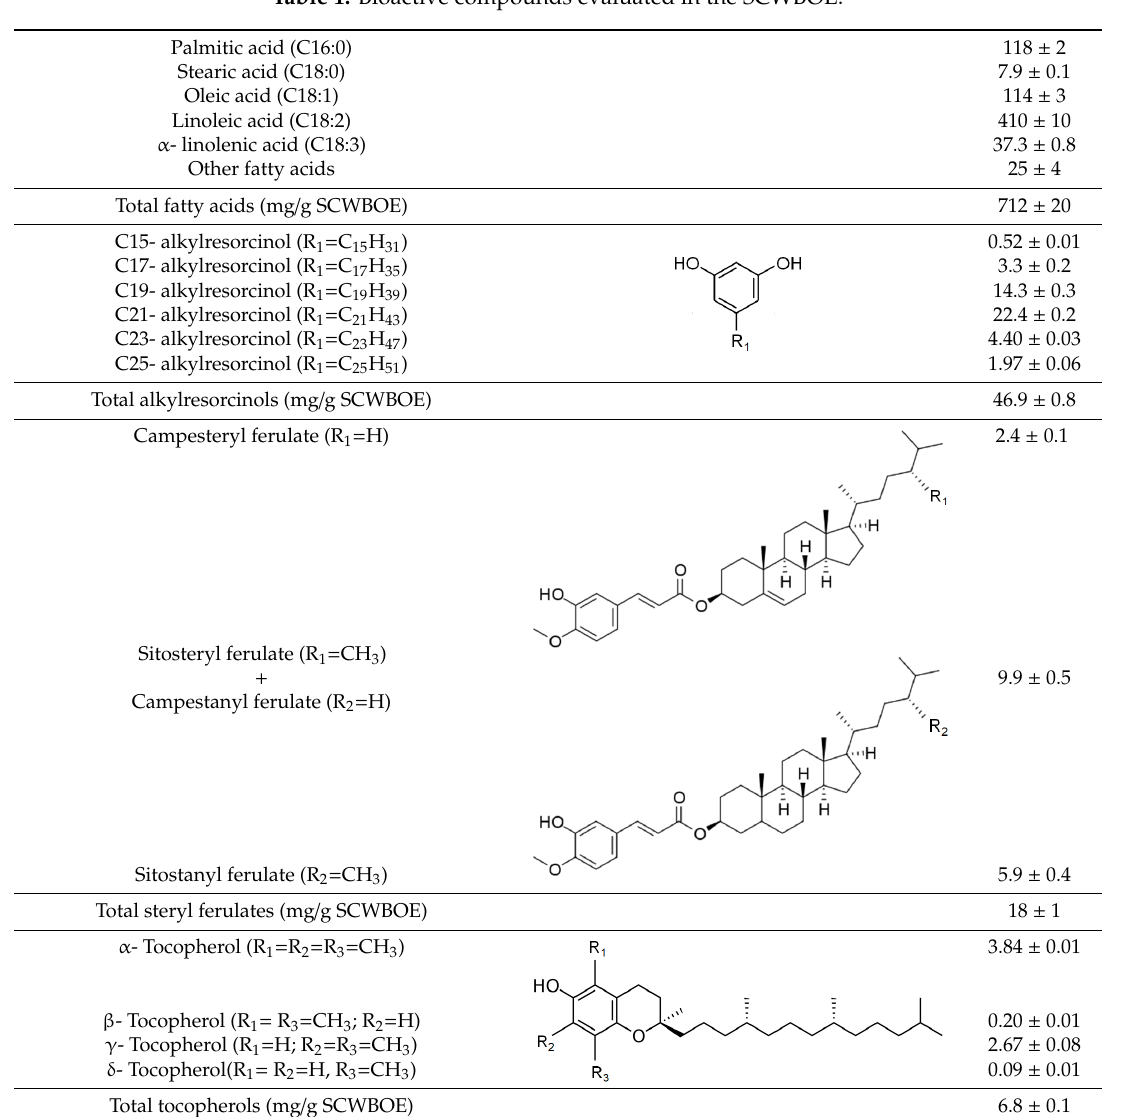
Table 1. Bioactive compounds evaluated in the SCWBOE.